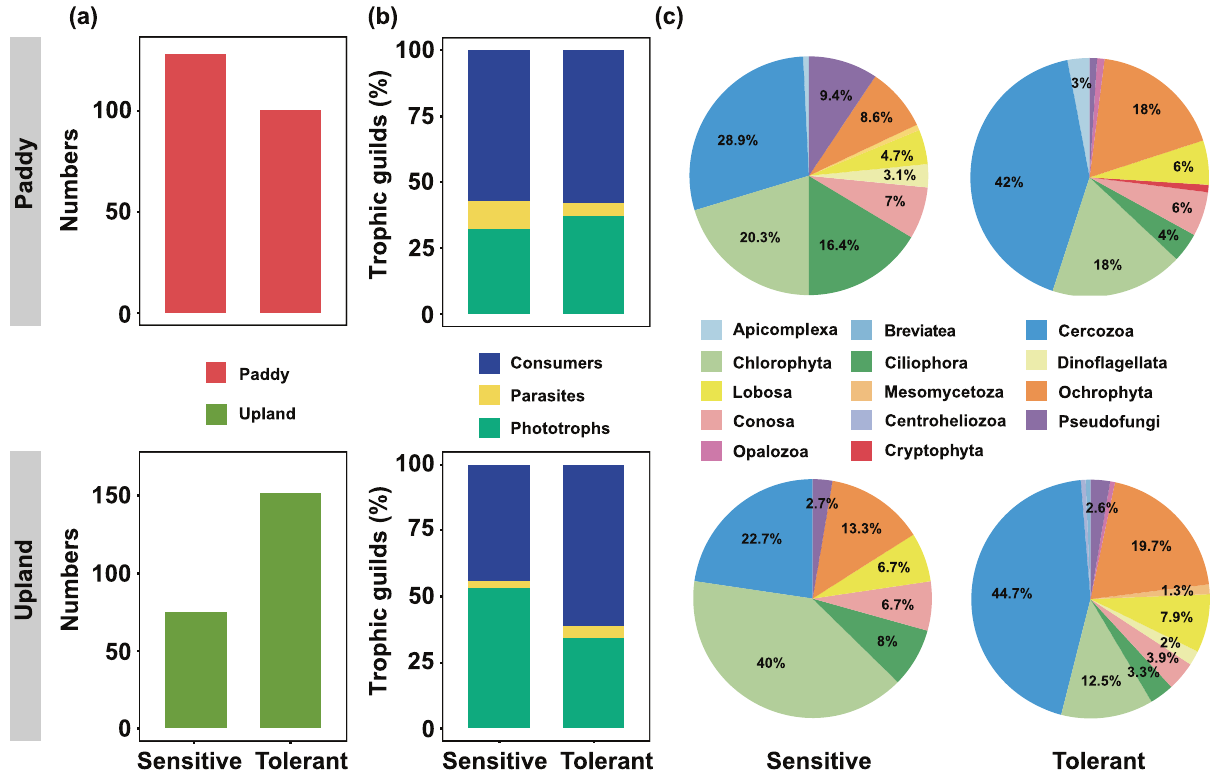
Fig. 2 Bioindicators of soil protists identi fi ed as Hg-sensitive or Hg-tolerant. Numbers of protistan bioindicators identi fi ed as Hg-sensitive or Hg-tolerant ( a ). Proportion of three trophic guilds of protistan bioindicators identi fi ed as Hg-sensitive or Hg-tolerant ( b ). The taxonomic compositions (at the phylum level) of protistan bioindicators identi fi ed as Hg-sensitive or Hg-tolerant ( c